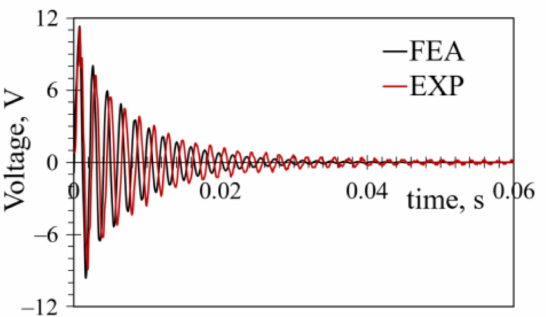
Figure 17. Comparison of experimental and transient FE FUC responses for a rectangular bimorph PEH excited by plucking its free end.